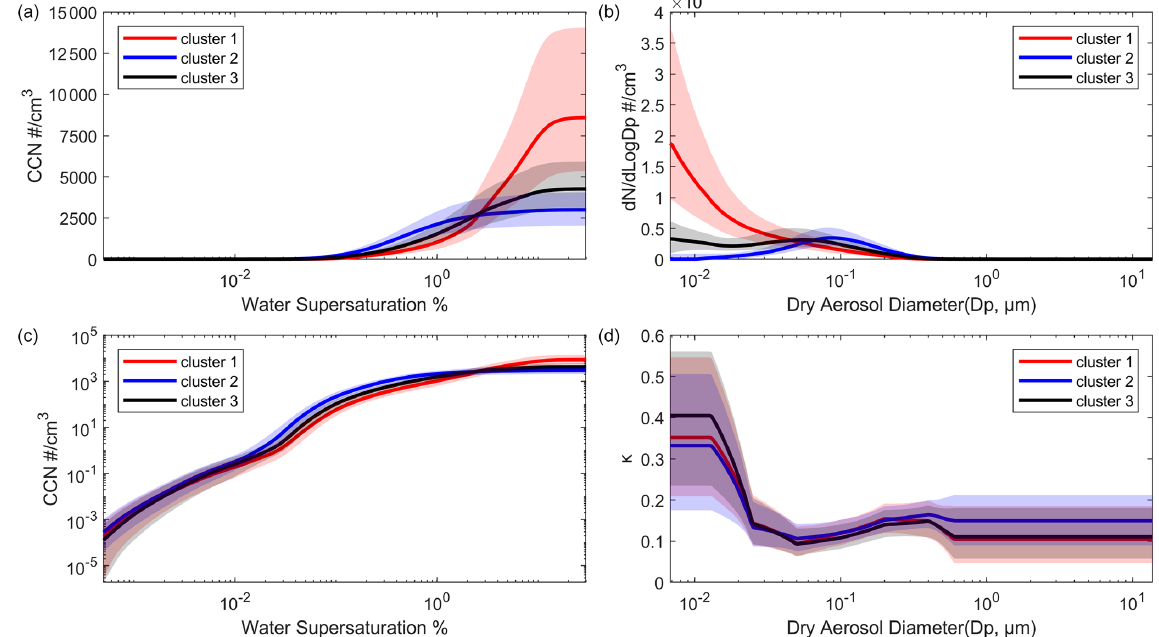
Figure 3. Clusters generated by the K -means clustering procedure. Cluster centers are shown by solid lines, with shaded region representing the 25th and 75th percentile bounds for spectra associated with each cluster. Panels (a) and (c) show the cluster CCN spectra, panel (b) shows the cluster size distributions, and panel (d) shows the cluster hygroscopicity parameter κ .